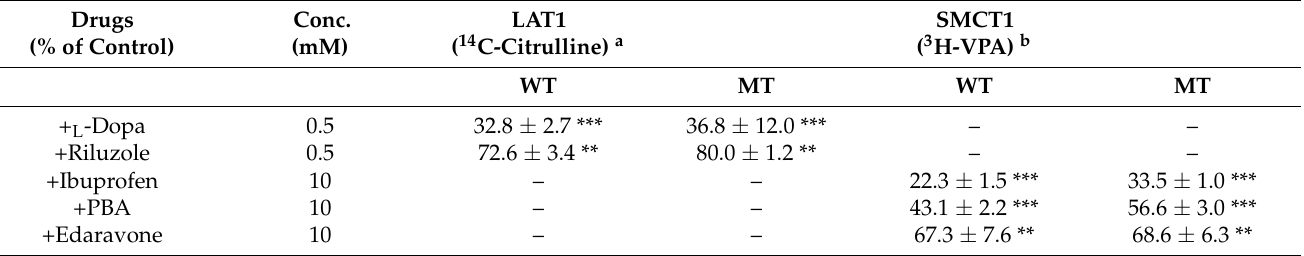
Table 2. Inhibition effect of therapeutics of ALS on the uptake rate of transporters substrate in ALS model cell